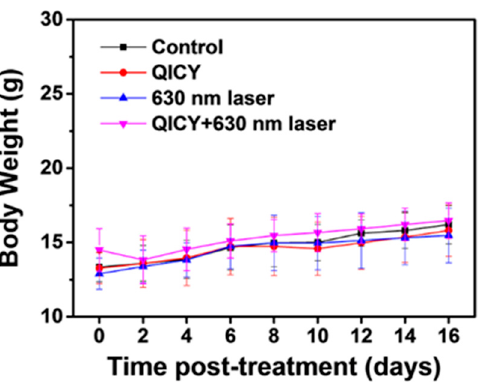
Figure 11. The body weights of the mice in the control, QICY, 630 nm laser irradiation, and QICY+ 630 nm laser irradiation groups after the different treatments ( n = 5 per group).